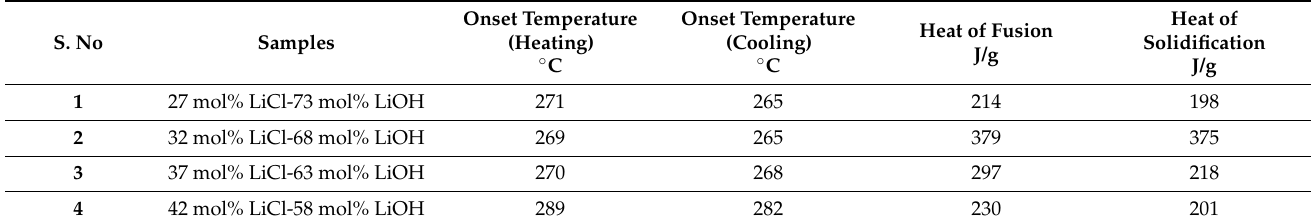
Table 4. Melting temperature and heat of fusion for four PCM